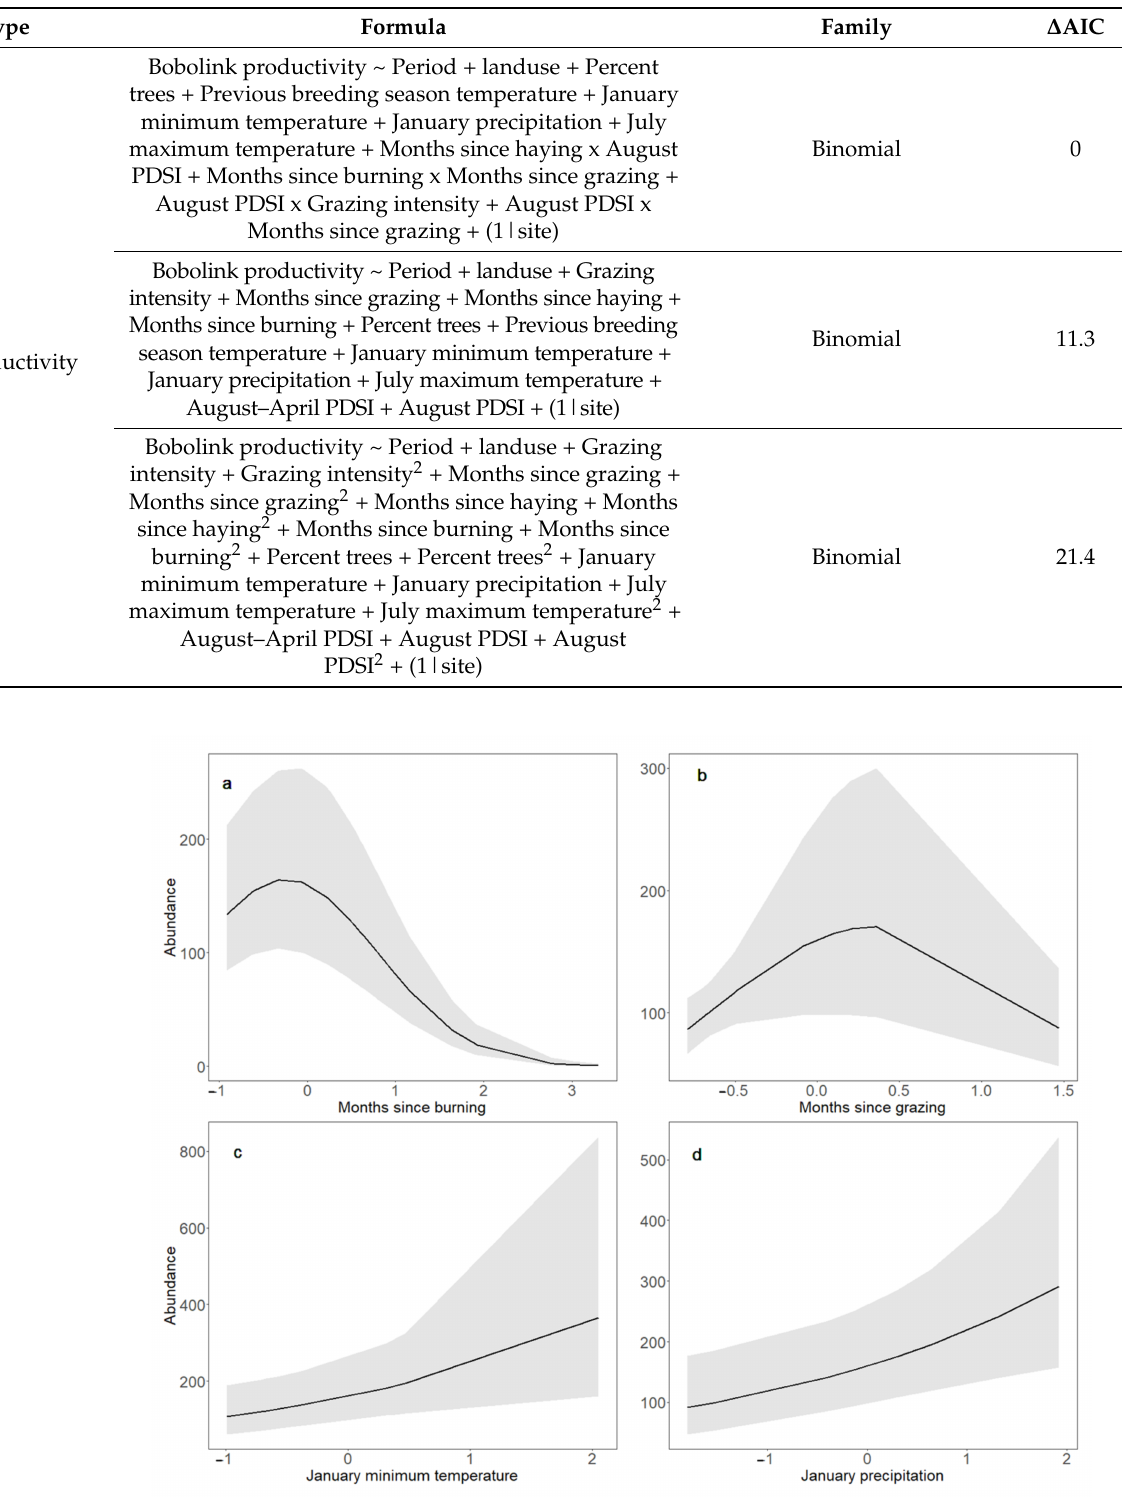
Figure 4. Bobolink adult abundance in response to time since burning ( a ), time since grazing ( b ), January minimum temperature ( c ) and January precipitation ( d ) from 2002 to 2019 in Nebraska, USA. Responses to each predictor were estimated using generalized linear mixed models while keeping the value of other predictors constant at their means (0 for standardized variables). The black line represents the mean, while the shaded area corresponds to the 95% confidence